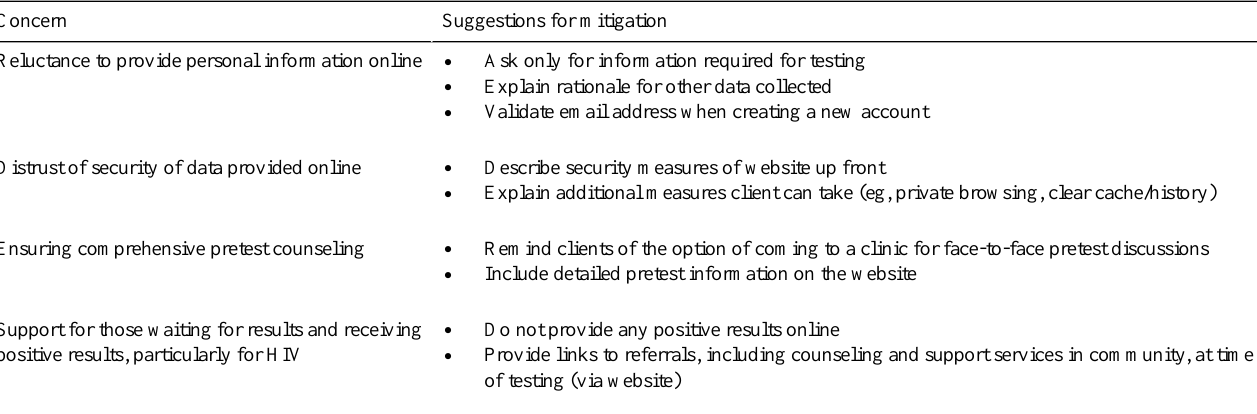
Table 3. Concerns with Internet-based sexually transmitted infection/human immunodeficiency virus (HIV) testing and corresponding strategies for mitigation expressed by